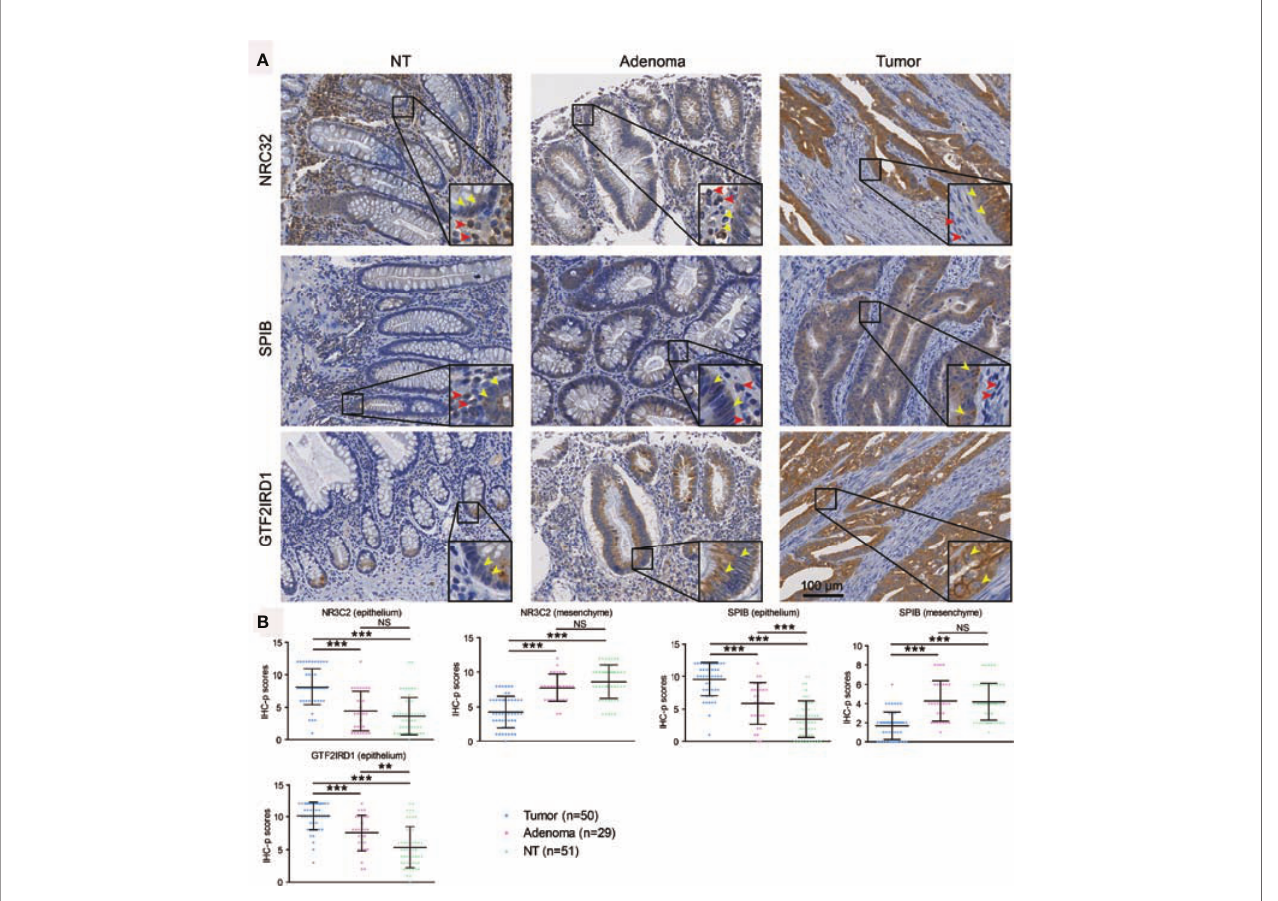
FIGURE 6 | Immunohistochemistry validation for SPIB, NR3C2, and GTF2IRD1 using tissue microarray. (A) Representative images showing protein expression in epithelium and stroma. Yellow and red arrows indicated positive staining in epithelium and stroma, respectively. (B) Immunohistochemistry scores for expressions of SPIB, NR3C2, and GTF2IRD1. ** indicated P < 0.01, *** indicated P < 0.001, and NS indicated no signi fi